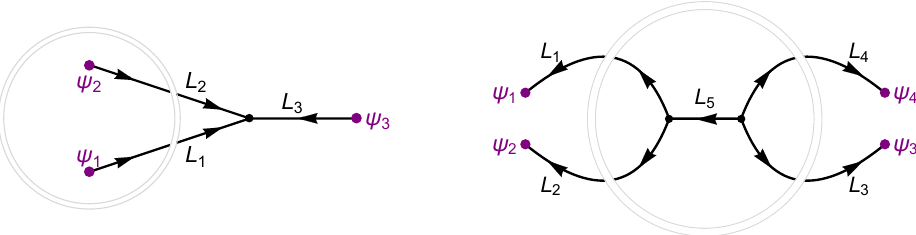
Figure 5 . Left: cutting a TDL graph along the gray circle and inserting a complete basis of states in H L is equivalent to replacing the defect operators (cid:9) 1 and (cid:9) 2 by their OPE, which is a defect 1 ; L 2 operator in H L . Right: a similar cut-and-insert procedure, where the defect operators inside 1 ; L 2 the circle are all junction vectors. The graph inside the smaller gray circle implements the map